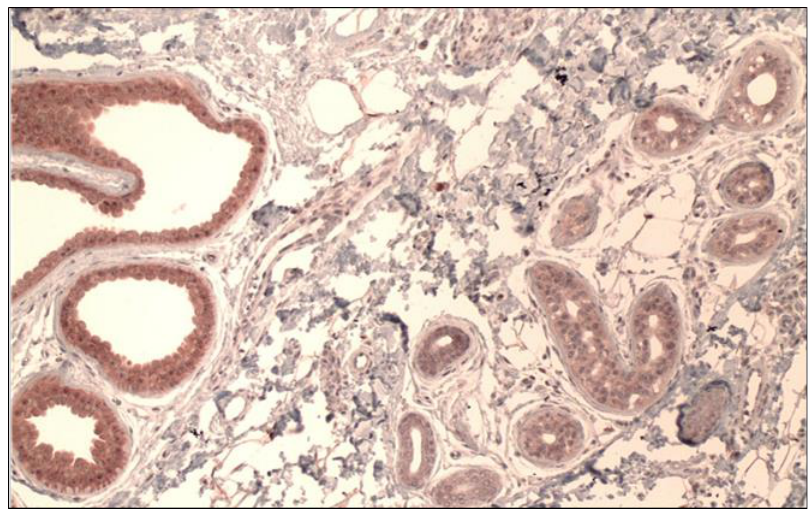
Figure 1. Expression of gankyrin in axillary skin. Apocrine glands (on the left) exhibit strong expression whereas eccrine glands (on the right) show background intensity. Original magnification 100×.